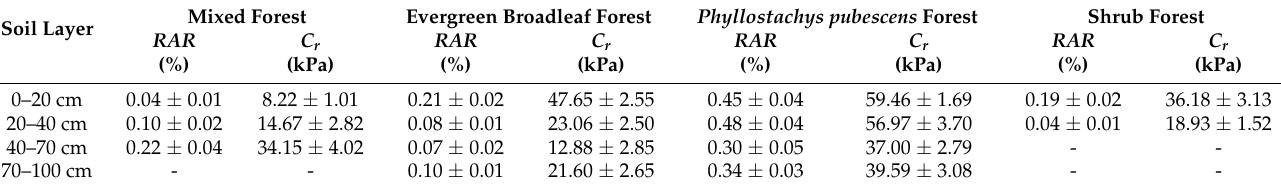
Table 2. Tensile strength and additional cohesion distribution of root